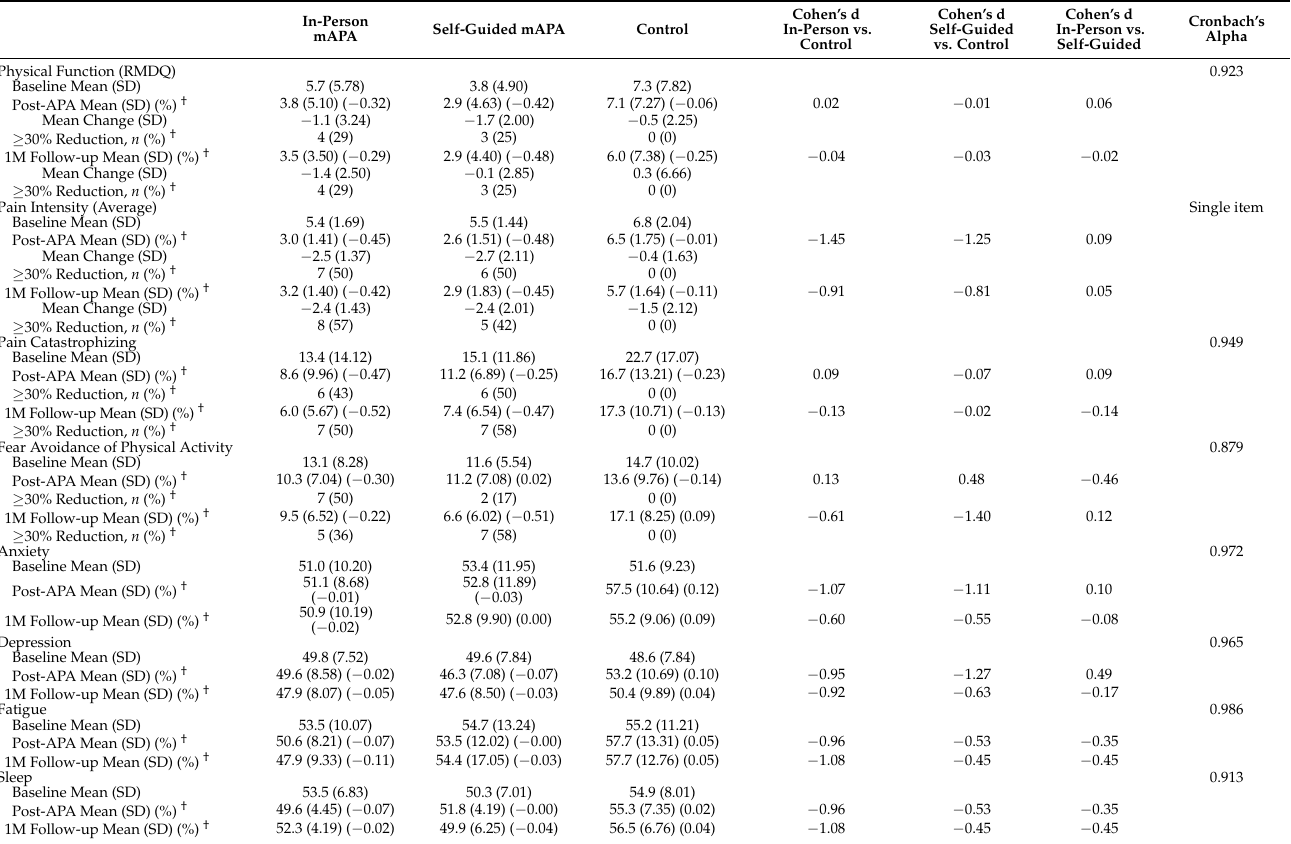
Table 3. Summary statistics for the study outcomes. In-Person mAPA Self-GuidedmAPA Control